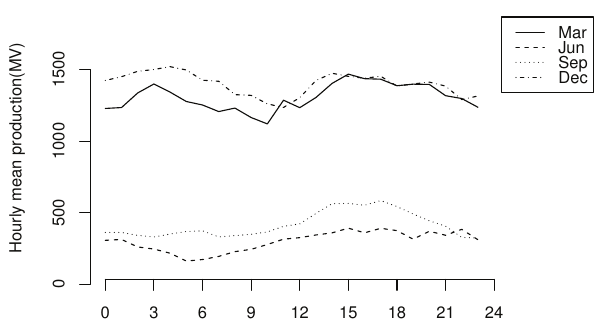
Figure 6. Average wind electricity generation per hour for each